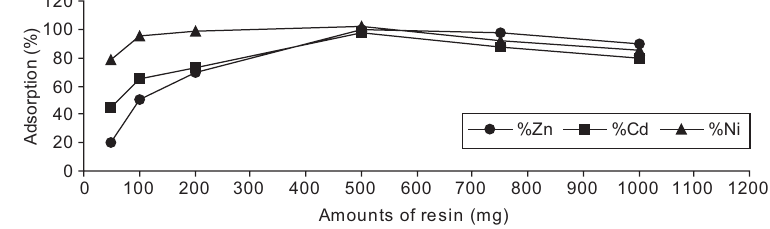
Figure 2 The effect of resin amount on the retention of metals.